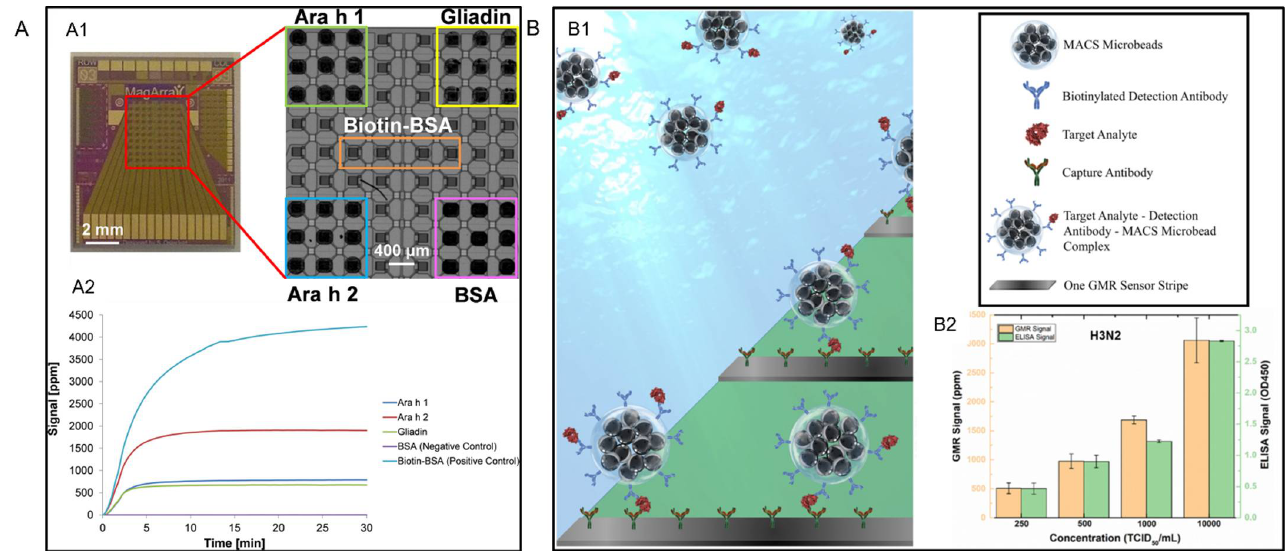
Figure 8. ( A , A1 ) Image of the GMR sensor array chip with multiplexed bioassay. ( A2 ) Real-time binding curve of 3 different allergens and the control groups. ( B , B1 ) Schematic diagram of the wash-free bioassay. ( B2 ) The detection of H 3 N 2 via GMR sensor and ELISA. ( A ) is reprinted with permission from Ref. [104], Copyright 2016, Elsevier B.V. ( B ) is reprinted with permission from Ref. [103], under the terms of the Creative Commons Attribution License (CC BY).